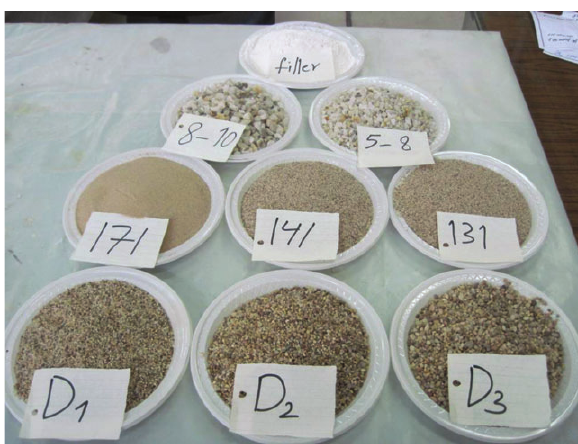
Figure 1 Sample of filler, fine, and coarse aggregate.